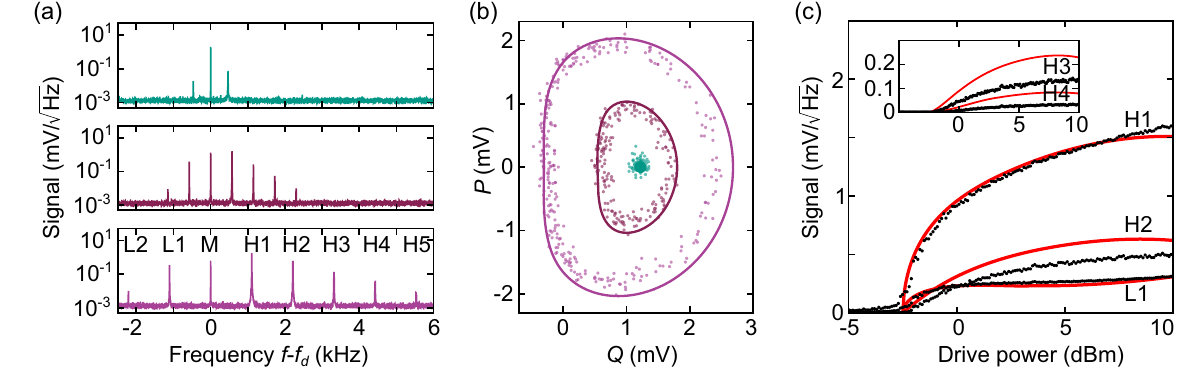
FIG. 3. Spectral vs homodyne measurement. (a) Frequency combs at drive power − 3 dBm (top), − 1 dBm (center), and 8 dBm (bottom). Data are taken from line cuts of Fig. 2(a) indicated by small arrows. (b) Trajectories in the rotating frame for the same drive powers as in (a). Data have been rescaled as described in Appendix B. Solid lines depict the theoretical model. (c) Amplitude of the satellites L 1 , H 1 , H 2 as well as H 3 and H 4 (magnified in the inset) from Fig. 2(a) (black dots), compared to the Fourier components obtained from the theoretical model (red